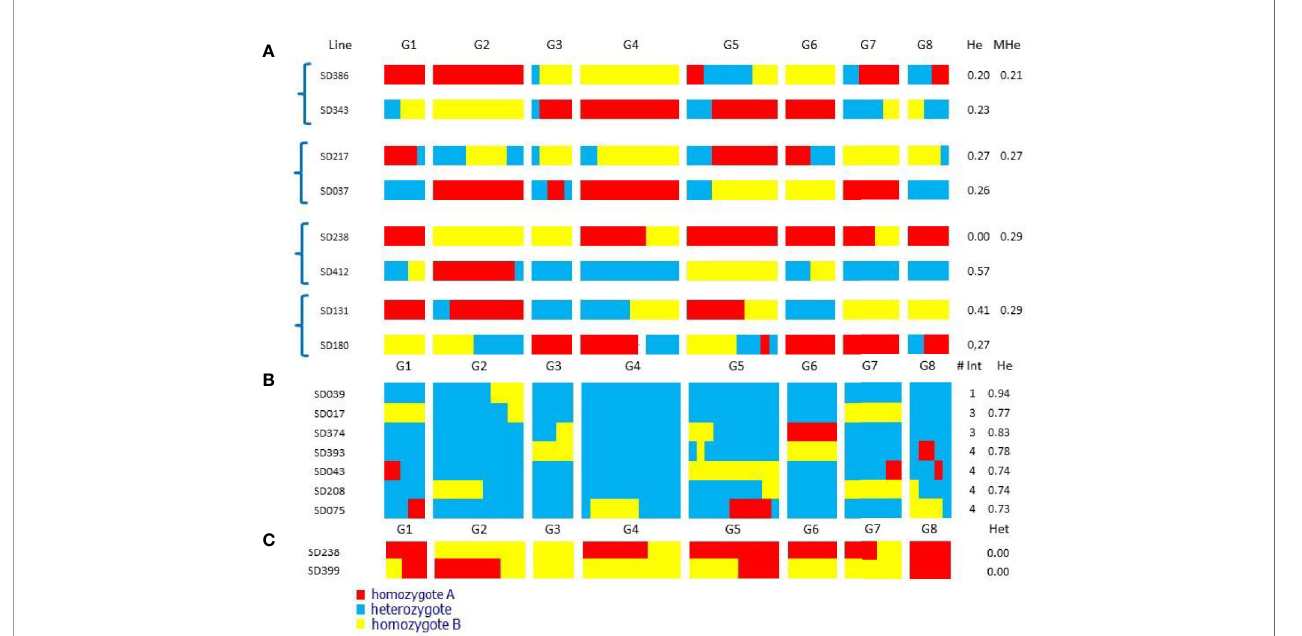
FIGURE 2 | Chromosome diagram of “ Sweet Dream ” F 2 selected individuals. G1-G8 peach linkage groups. He: proportion of heterozygous loci; MHe: mean He for each pair of complementary lines. # Int: introgression number (A) Pairs of nearly-homozygous complementary lines selected for Resynthesis A; with high probability their offspring will produce individuals very close to ‘ Sweet Dream ’ . (B) Selected individuals for Resynthesis B, nearly identical to ‘ Sweet Dream ’ . (C) Fully homozygous F2